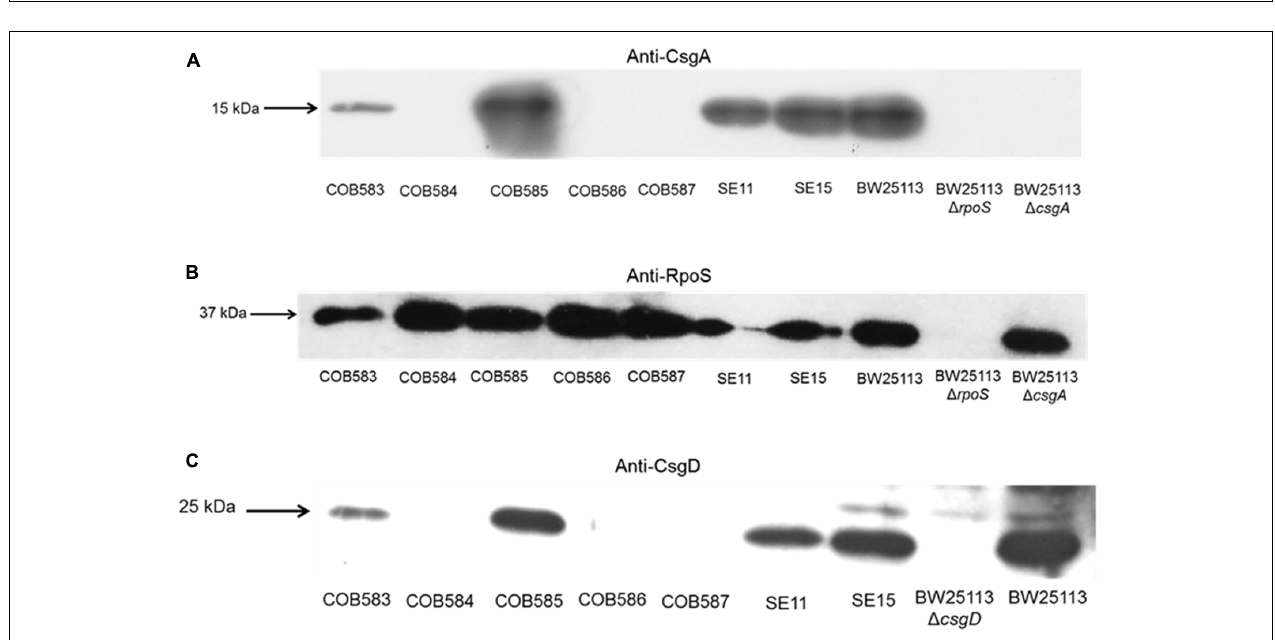
FIGURE 1 | Curli production among soil-persistent Escherichia coli . Macrocolonies of soil-persistent, commensal and control strains were grown on Congo Red-containing Yeast Extract and Casamino acid (CR-YESCA) agar at 28 ◦ C for 48 h. E. coli BW25113 was used as the positive control and E. coli BW25113 (cid:49) csgA was the negative control.